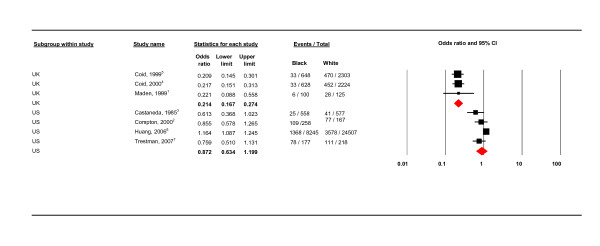
US and UK studies.